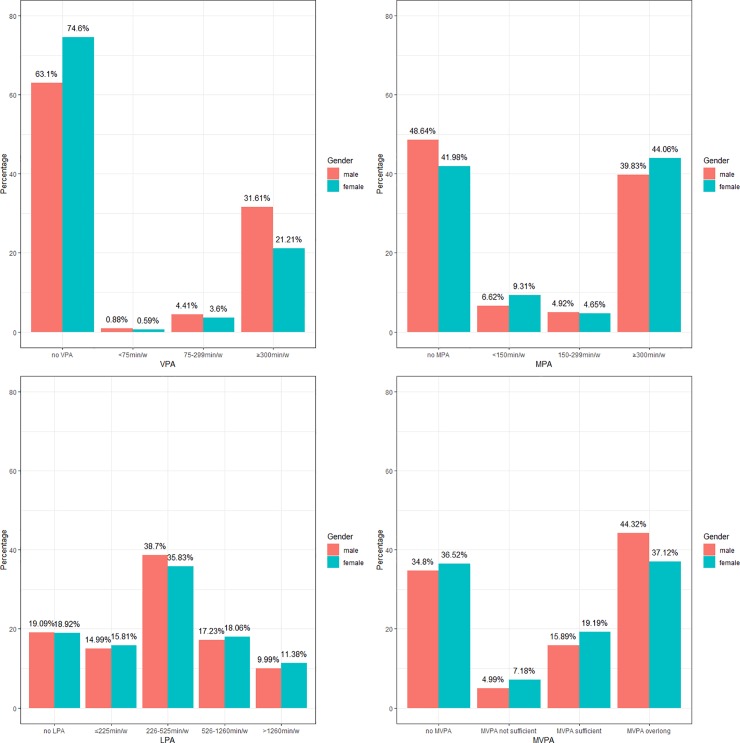
Volume of VPA, MPA, LPA and MVPA per week in men and women.